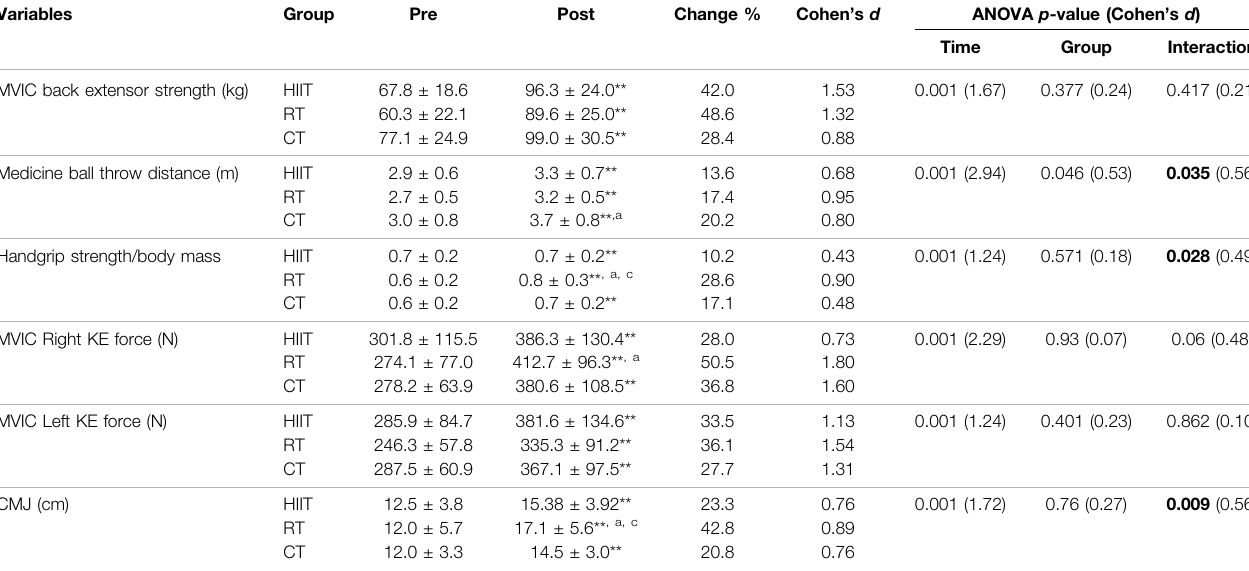
TABLE 6 | Effects of 9 weeks of training on strength and jumping tests (mean ± SD). Variables